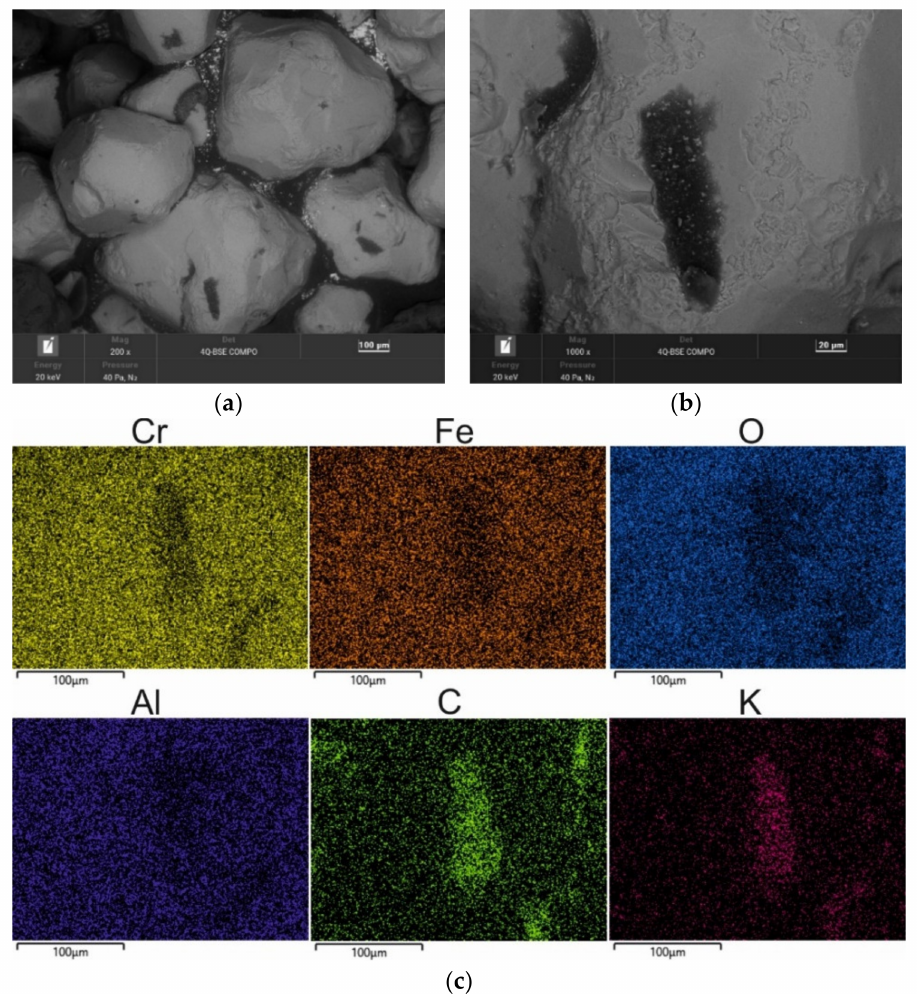
Figure 7. SEM image of 5 min MR5M-reclaimed sand: ( a ) mag. 200 × ; ( b ) mag. 1000 × ; ( c ) EDS map of element distribution in the analysed area of MR5M reclaimed sand.